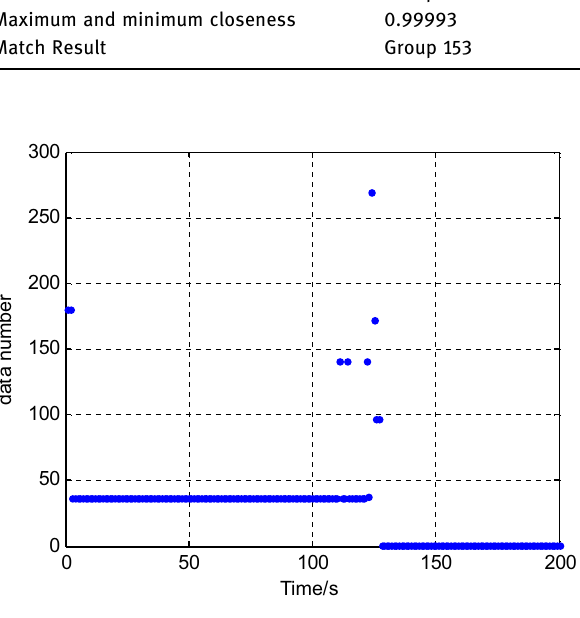
Figure 8: Identi fi cation results of trajectory matching sequence number based on fuzzy relative entropy.